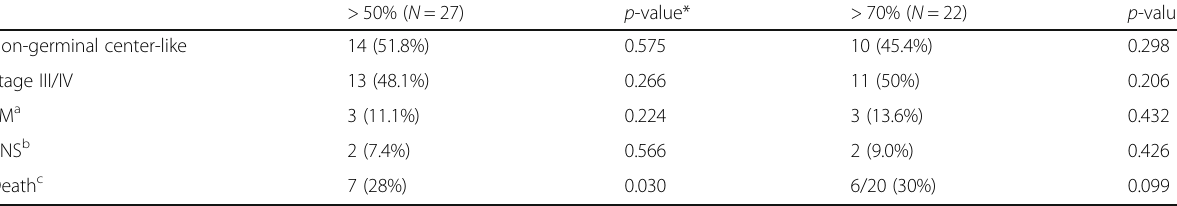
Table 4 “ Double- expressor ” lymphomas and clinical evolution, according to the BCL2 cut-off adopted in the IHC (50% or 70%) > 50% ( N =